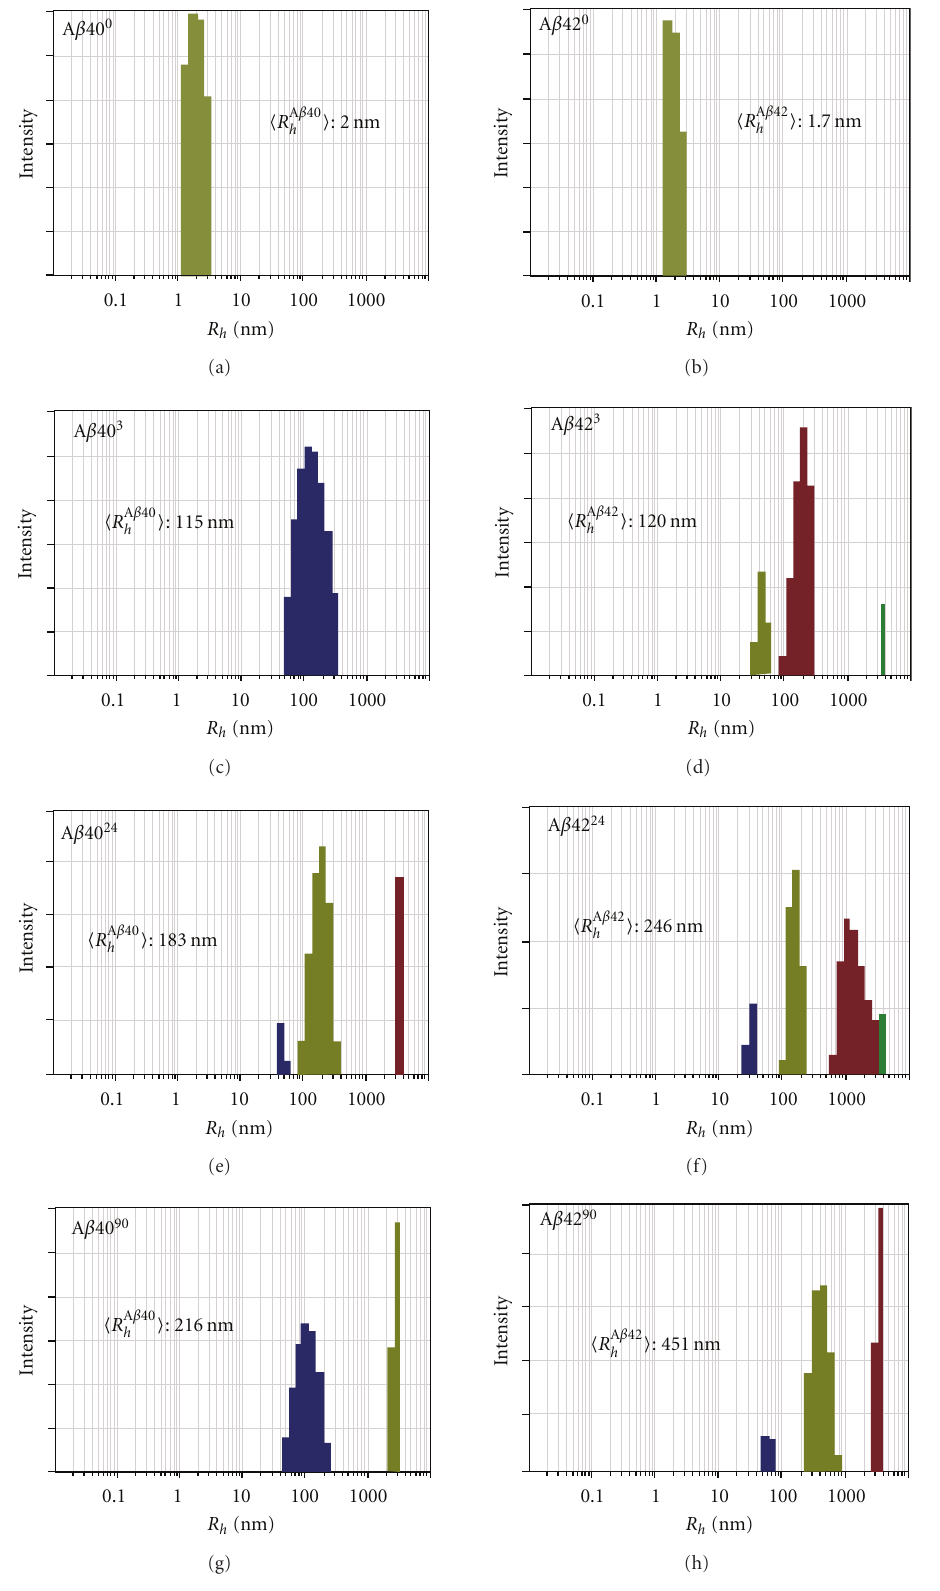
Figure 1: Dynamic light scattering of endocytic A β . A time-dependent increase in the average hydrodynamic radius ( R h ) was observed with incubation of A β under endocytic conditions. At each time point, a variety of aggregates are